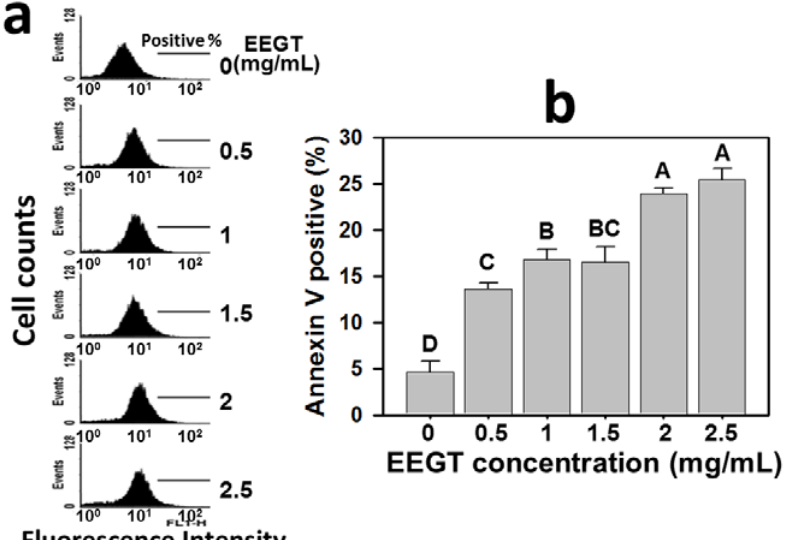
Figure 2. Ethanolic extracts of G. tenuistipitata (EEGT) induced apoptosis of Ca9-22 oral cancer cells. ( a ) Cells treated with different concentrations (0 to 2.5 mg/mL) of EEGT for 24 h were stained with annexin V-FITC. Positive % is indicated in each panel; ( b ) Quantificative analysis of annexin V-positive population. Data are presented as mean ± S.D. (n = 3). Differences between treatments of different concentrations containing the same capital letter at the top of each column are not